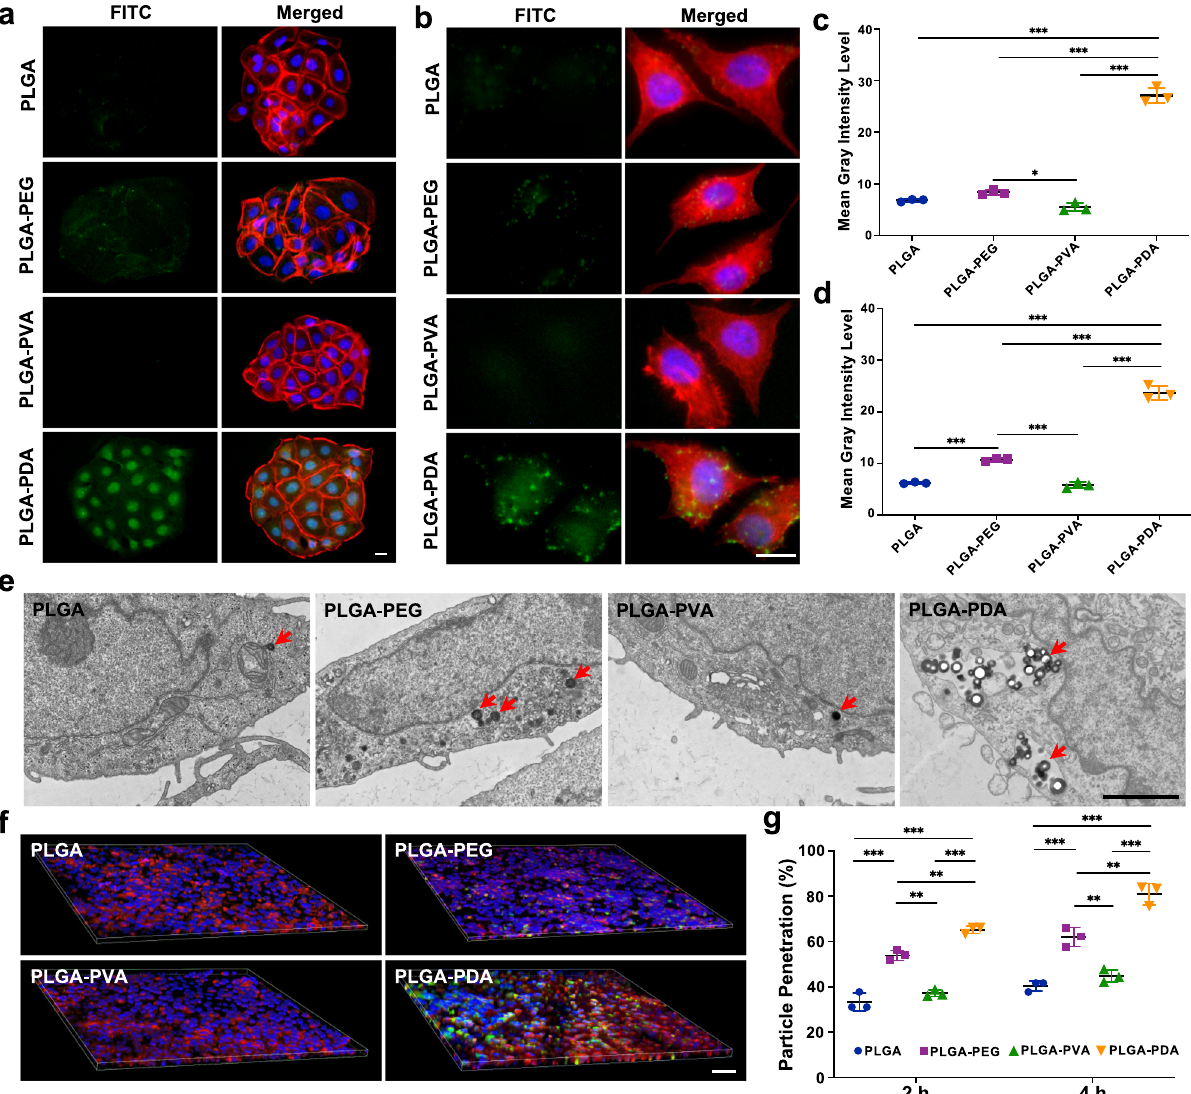
Fig. 5 Cellular uptake of NPs in vitro. a, b Fluorescence image of the cellular uptake of different NPs after incubation for 2 h in HOK and HGECs. Scale bars: 20 μ m. PLGA: poly(lactic-co-glycolic acid), PEG: poly(ethylene glycol), PVA: poly(vinyl alcohol), PDA: polydopamine. c, d Quanti fi cation of the fl uorescence intensity of different NPs obtained from fl uorescence images of HOK and HGECs. * P = 0.021; *** P < 0.001. e TEM imag e s of the cellular transport and localization of different NPs in HOK after incubation for 2 h. Scale bar: 2 μ m. f 3D images of the cellular transport of NPs in the TR146 cell monolayer. Scale bar: 100 μ m. g Percentage of NPs transported through the TR146 monolayer. ** P < 0.01; *** P < 0.001. All data are Mean± S.D. n = 3 independent cells per group. Statistics was calculated by one-way ANOVA followed by Tukey ’ s post-test. Exact P values are given in the Source Data fi le. Source data are provided as a Source data fi